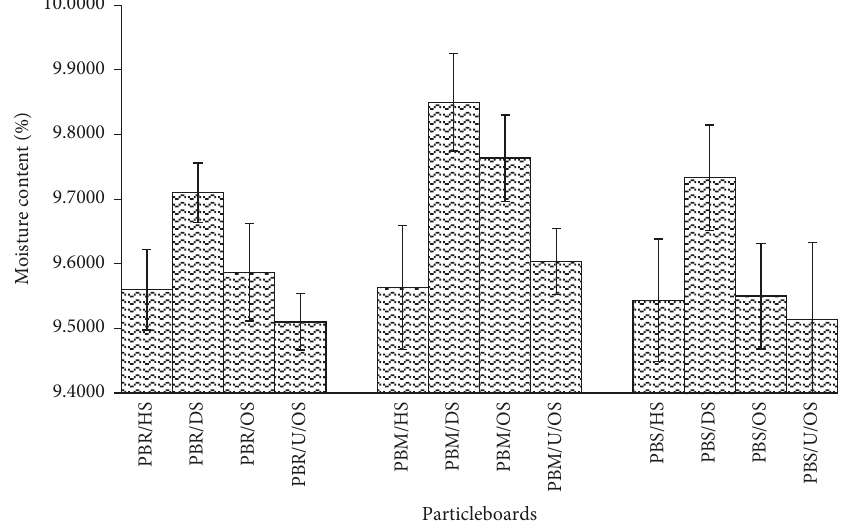
Figure 3: Moisture content of